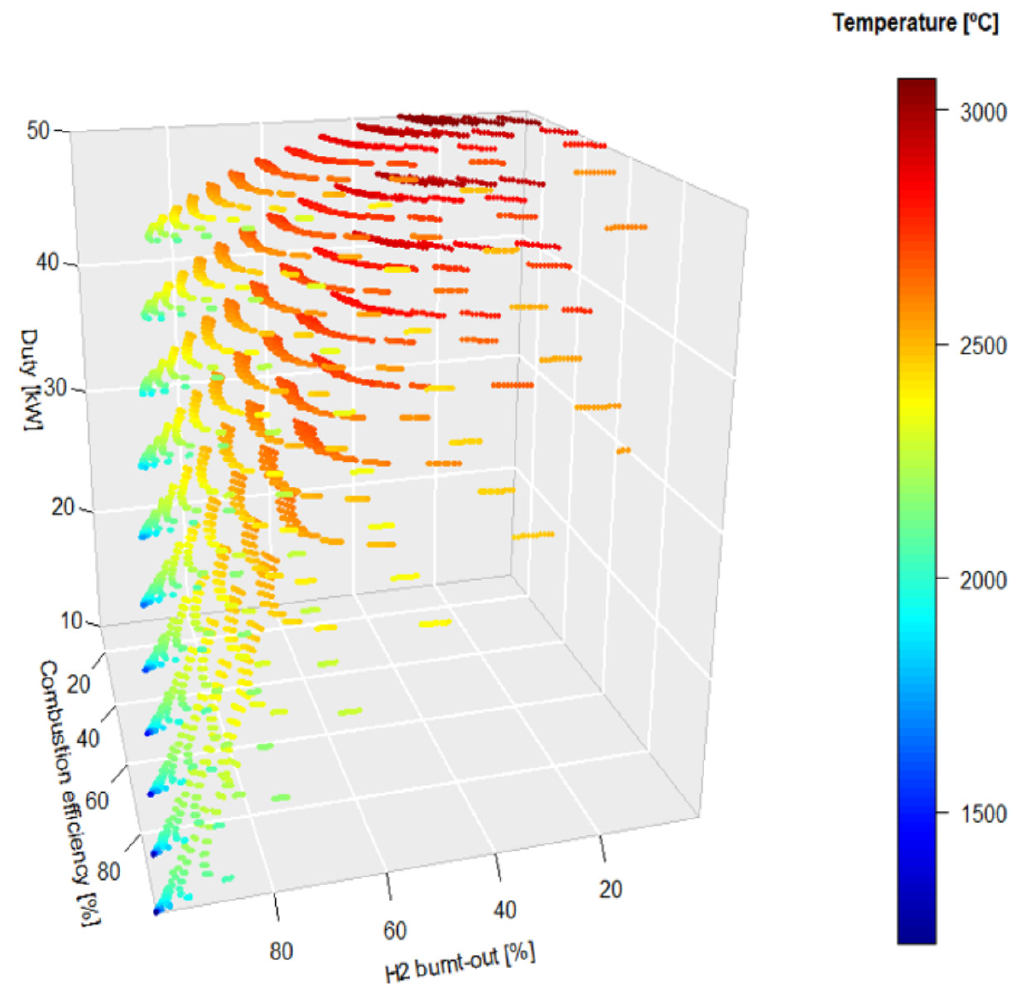
Figure 5. Initial conditions of the sensitivity analysis.